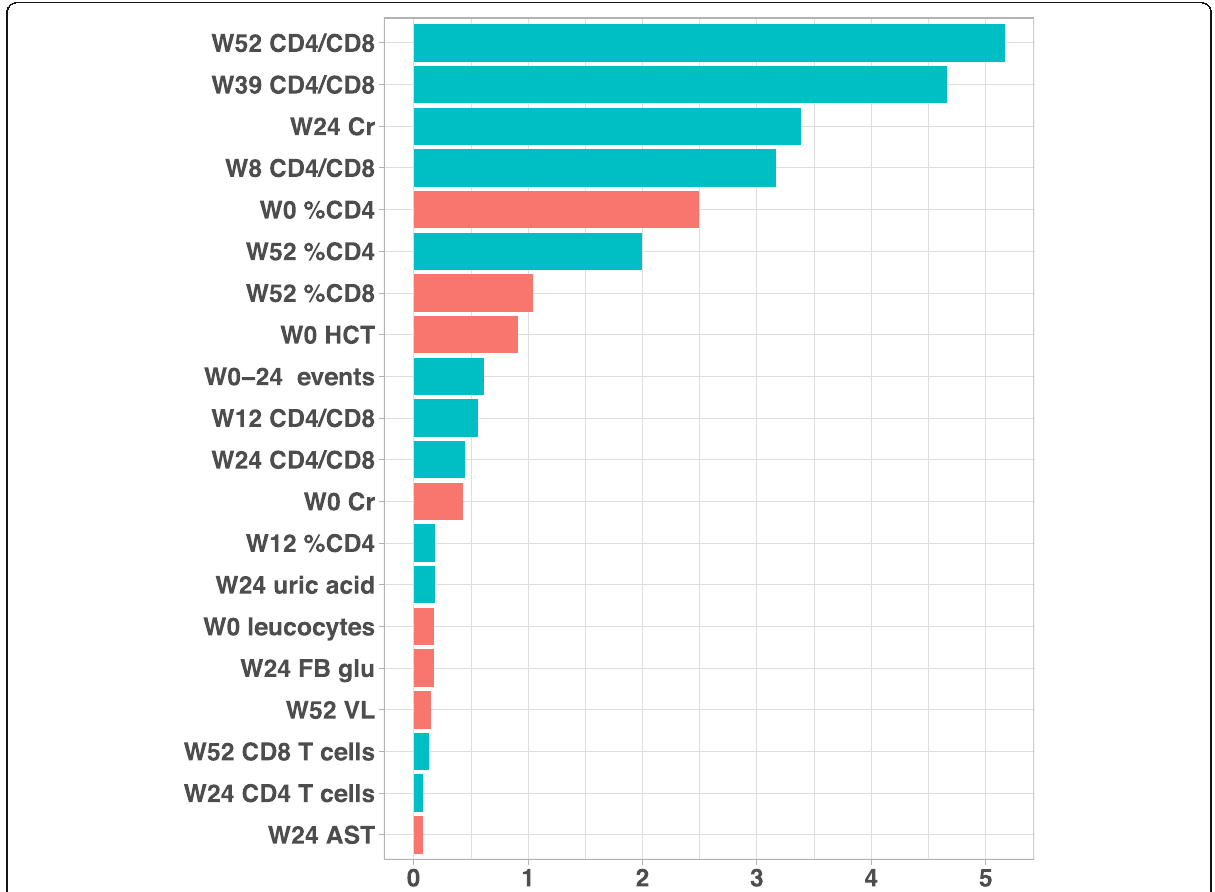
Fig. 2 LASSO-selected variables with the highest coefficients (top 20). Plotted values correspond to transformed coefficients. For each variable, the transformed value equals the natural logarithm of the absolute value plus 1. Green, coefficients with positive value. Salmon, coefficients with a negative value. W, week under treatment; Cr, serum creatinine; %CD4, % CD4 T cells; HCT, hematocrit; FB glu, fasting blood glucose; VL, viral load (HIV mRNA copies/mL blood); AST, Aspartate